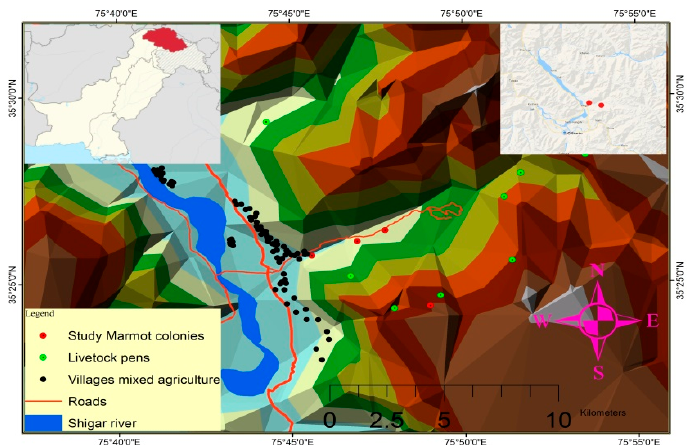
Figure 1. Study area in the Shigar Valley, Karakoram Range in North-East Pakistan, showing the location of the four marmot ( Marmota caudata aurea ) colonies in relation to roads, livestock pens, and villages, at different elevations.